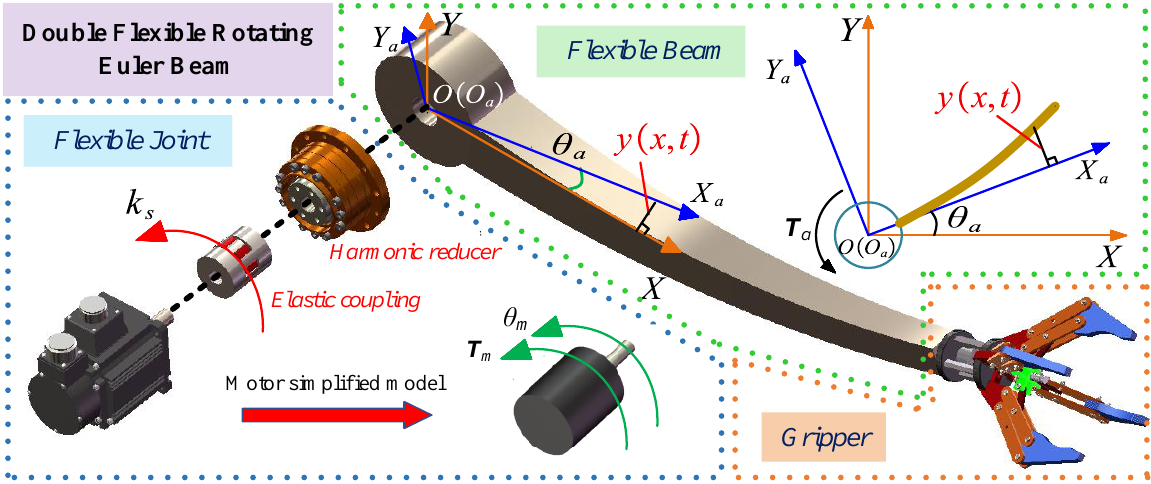
Figure 1. Dynamics model diagram of a system with two flexible bodies.